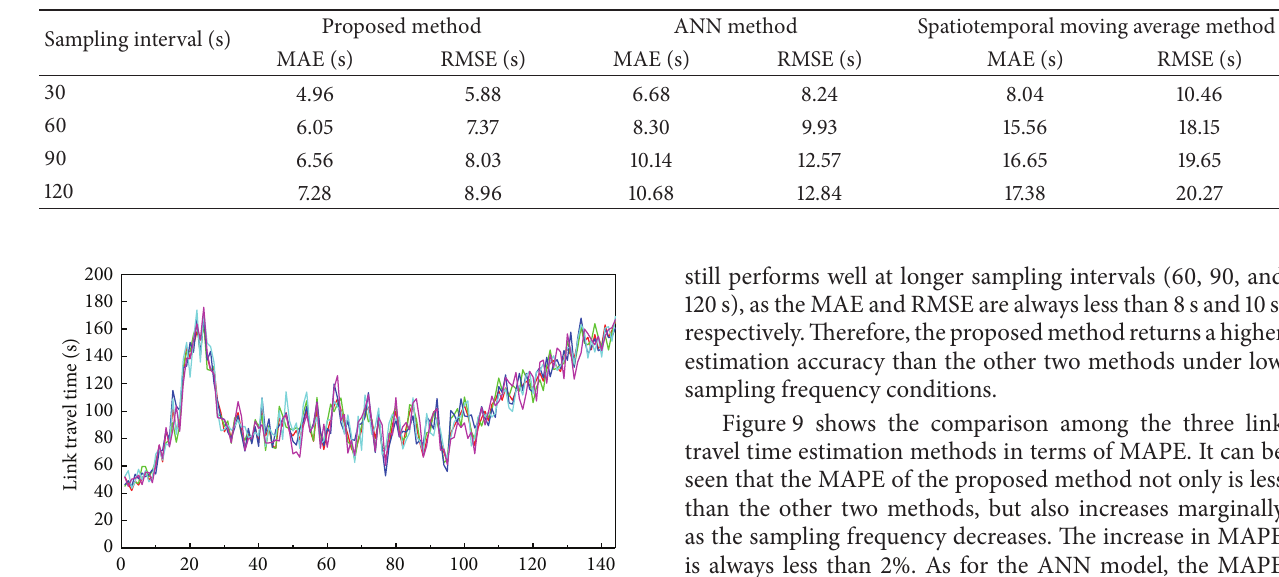
Table 2: Performance measurements of the three methods.